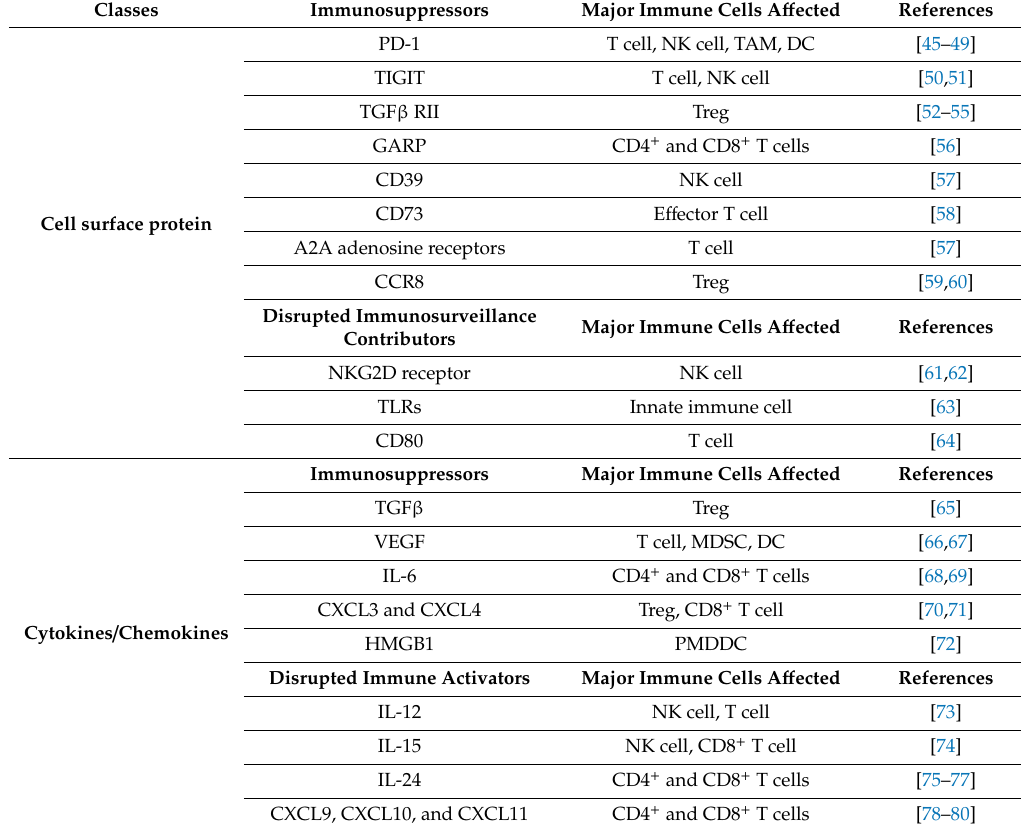
Table 1. Factors that contribute to immunosuppression in the TME of